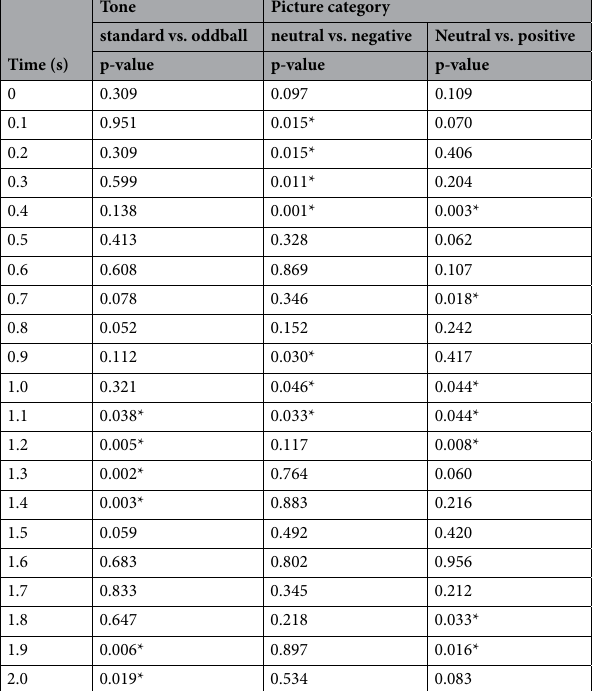
Table 1. Results of t-test in time course data of the pulse strength. 0 s indicates the onset of picture presentation, and 0.8 s indicates the onset of tone presentation, respectively. Significant difference (α = 0.05) in the strength of the pulses are denoted by the